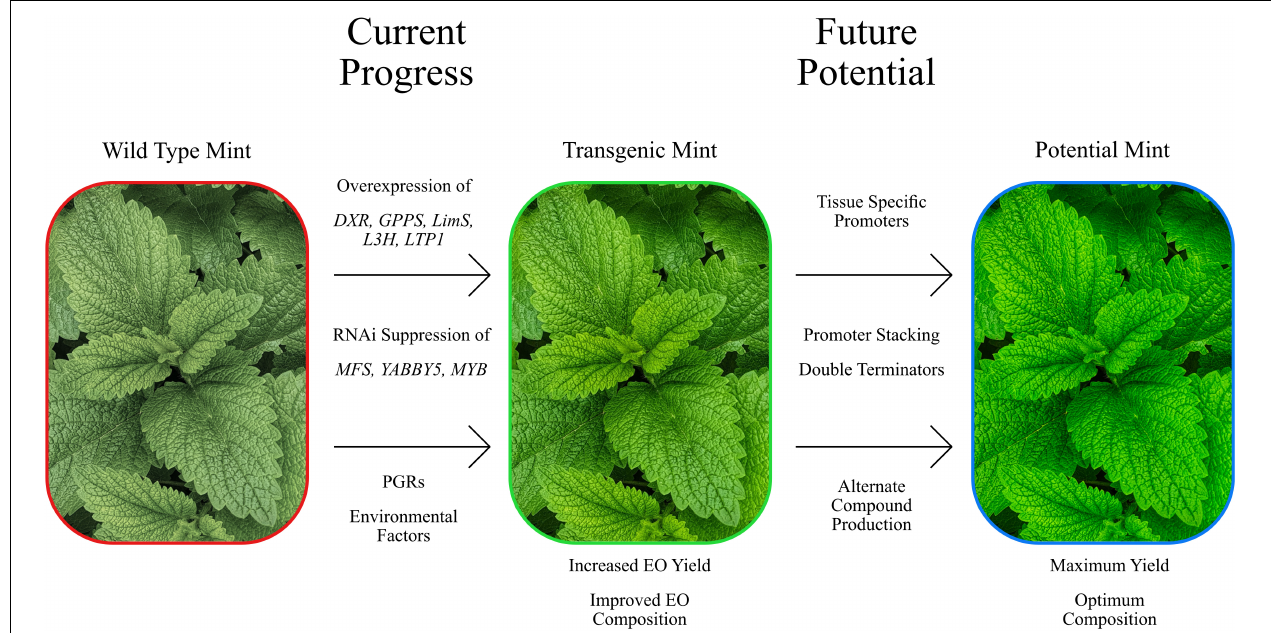
FIGURE 2 | Summary image of the manipulation of Mentha , both present and future. Showing some of the current genetic manipulation attempts that have demonstrated efficacy at modifying EO yields compositions. Newer approaches have the potential to improve on this